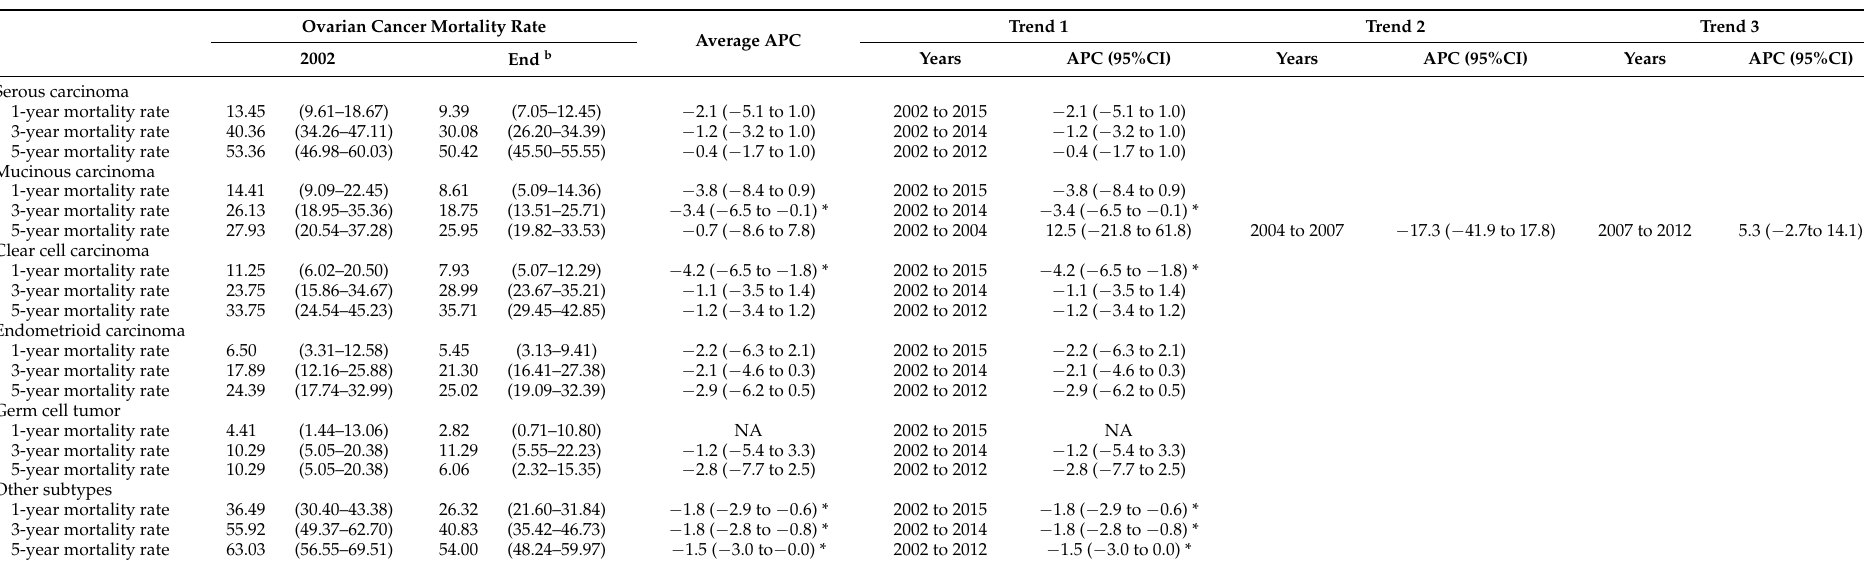
Table 7. Joinpoint analysis of overall mortality a for ovarian cancer patients with different histological subtypes in Taiwan during